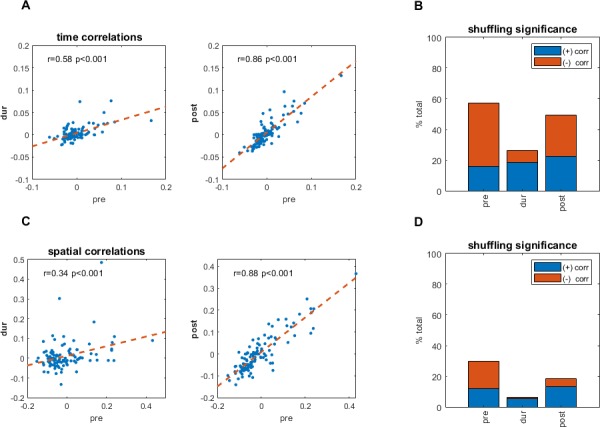
Temporal and spatial correlations pre- and during inactivation, for simultaneously recorded cell pairs.(A) Temporal cross correlations pre- and during inactivation, and pre- and post-inactivation, with correlation value (r), and corresponding p-value. (B) Proportions of significant temporal correlations, according to shuffling measures, pre-, during, and post-inactivation, including the sign (positive, negative) of the correlation value. (C) Same as (A) but for spatial correlations of the firing pattern in the arena at [0,0]. (D) Same as (B) but for spatial correlations of the firing pattern in the arena at [0,0].